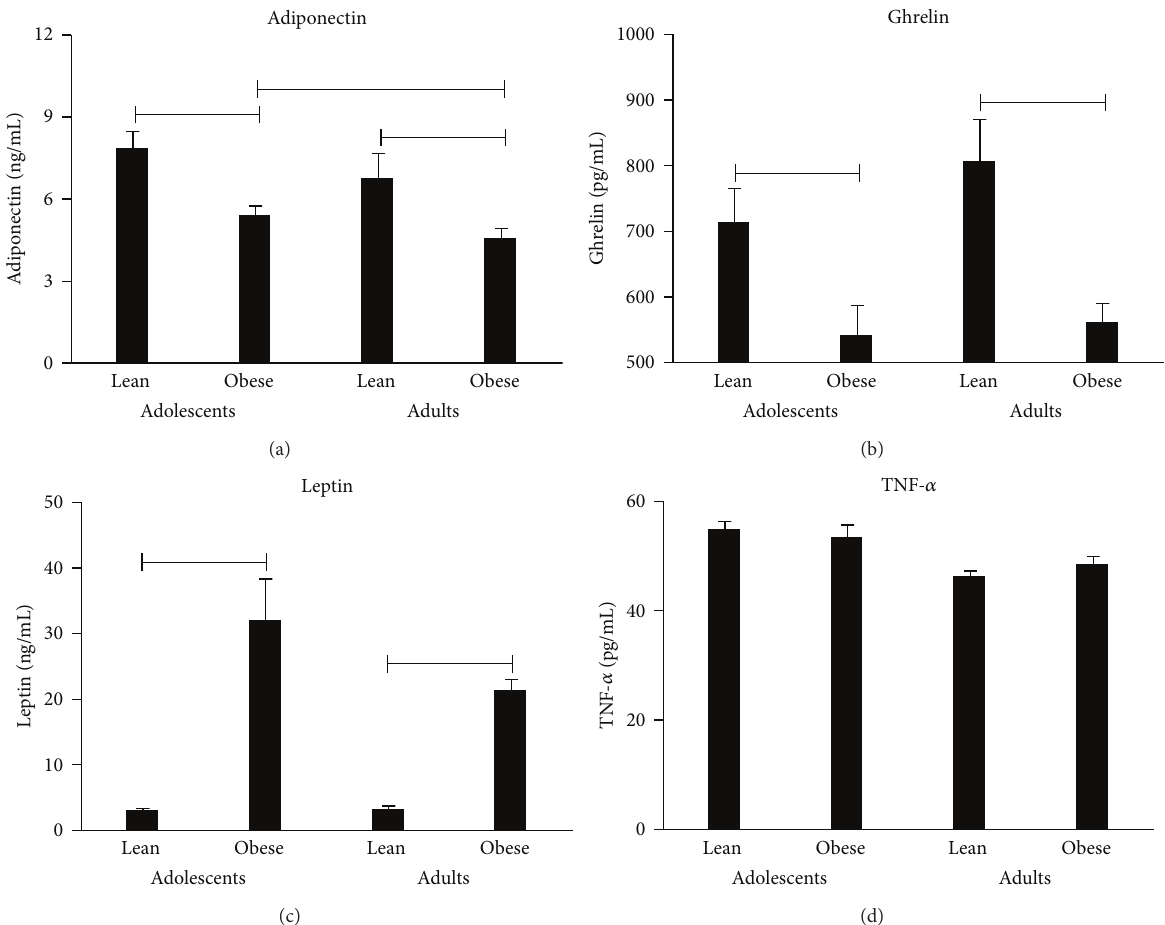
Figure 1: Circulating levels of adiponectin, ghrelin, leptin, and TNF- 𝛼 in lean and obese adolescents and adults. Comparisons: 𝑃 < 0.05